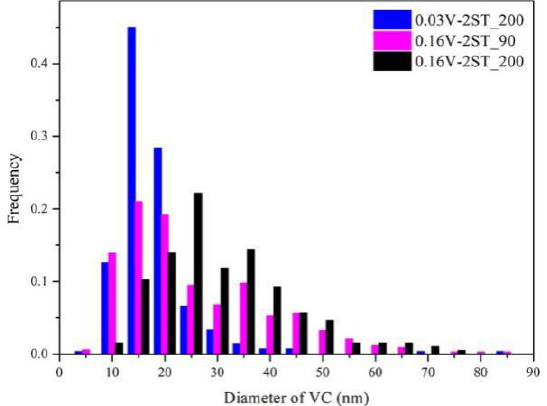
Figure 13. TEM micrographs of carbon extraction replica specimens: ( a , b ) 0.03V-2ST_200, ( c , d ) 0.16V-2ST_90, and ( e , f ) 0.16V-2ST_200.